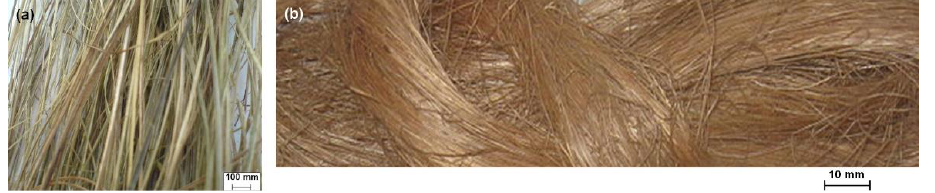
Figure 1. Phormium fiber extraction: ( a ) initial appearance of the leaves and ( b ) appearance of the fibrous material after stripping. fibrous material after